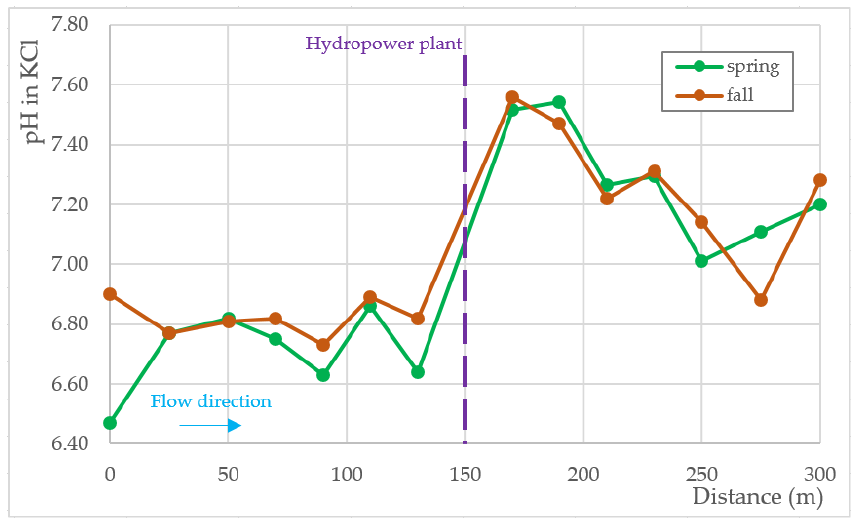
Figure 12. Changes in pH in KCl values in sediments in spring and fall near the hydropower plant on the Ślęza River, along with the geochemical classification.